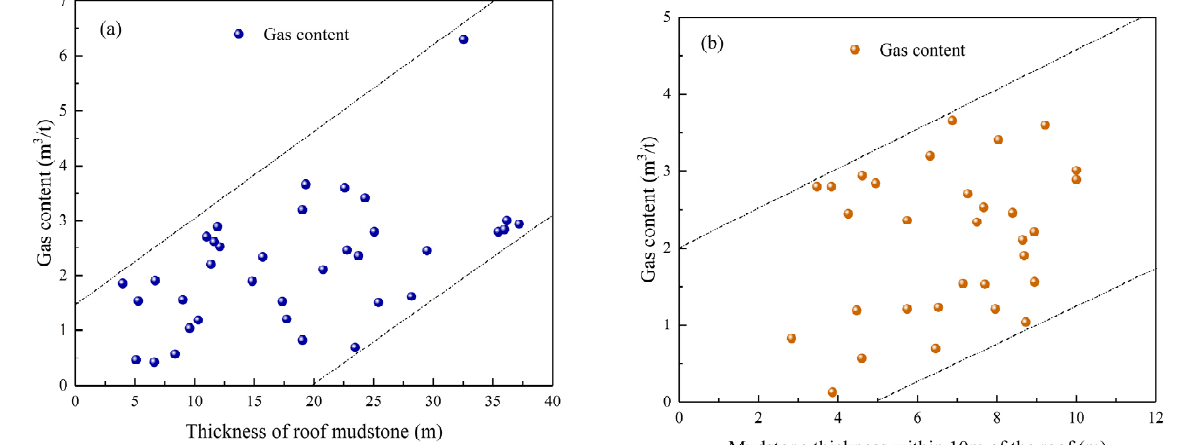
Figure 7. Relationship between gas content and roof: ( a ) mudstone thickness; ( b ) mudstone thickness within 10 m of the roof.